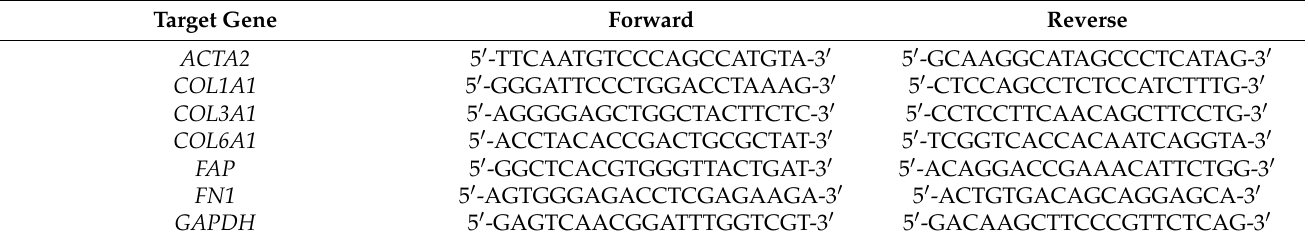
Table 2. Human primer for used